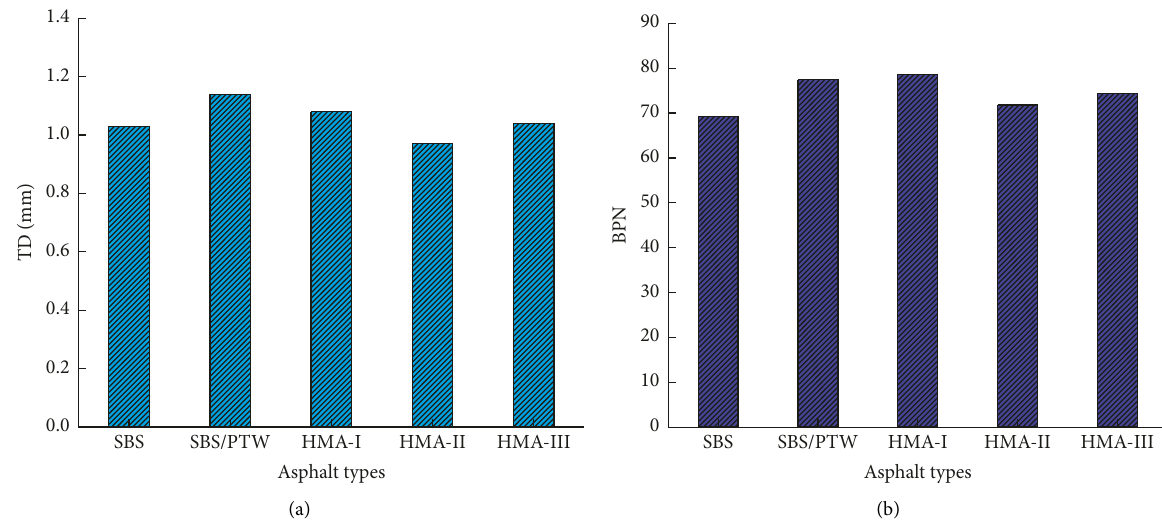
Figure 9: Skid resistance test results of asphalt mixture. (a) Texture depth test. (b) British pendulum number